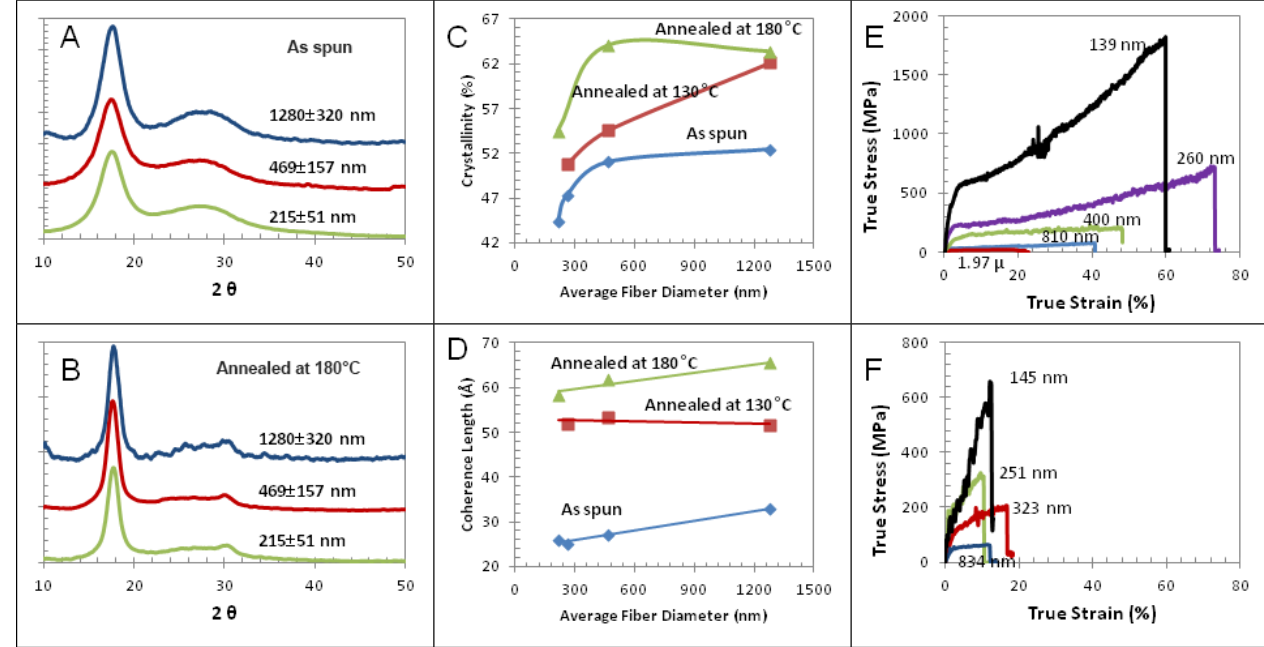
Figure 3. Effects of PAN composite nanofiber (with succinite and SiO 2 nanopowder) diameter and annealing on crystallinity and mechanical behavior. Wide-angle X-ray diffractograms for ( A ) as-spun and ( B ) annealed composite nanofiber mats with different average fiber diameters (XRD spectra for composite nanofibers annealed at 130 and 180 °C were qualitatively similar); variations in ( C ) XRD crystallinity and ( D ) coherence length as functions of average fiber diameter; representative stress–strain diagrams for ( E ) individual as-spun and ( F ) annealed PAN composite nanofibers (with succinite and SiO 2 nanopowder) of different diameters. The same strain scale is used in panels ( E , F ) for easier comparison and evaluation of annealing effects.